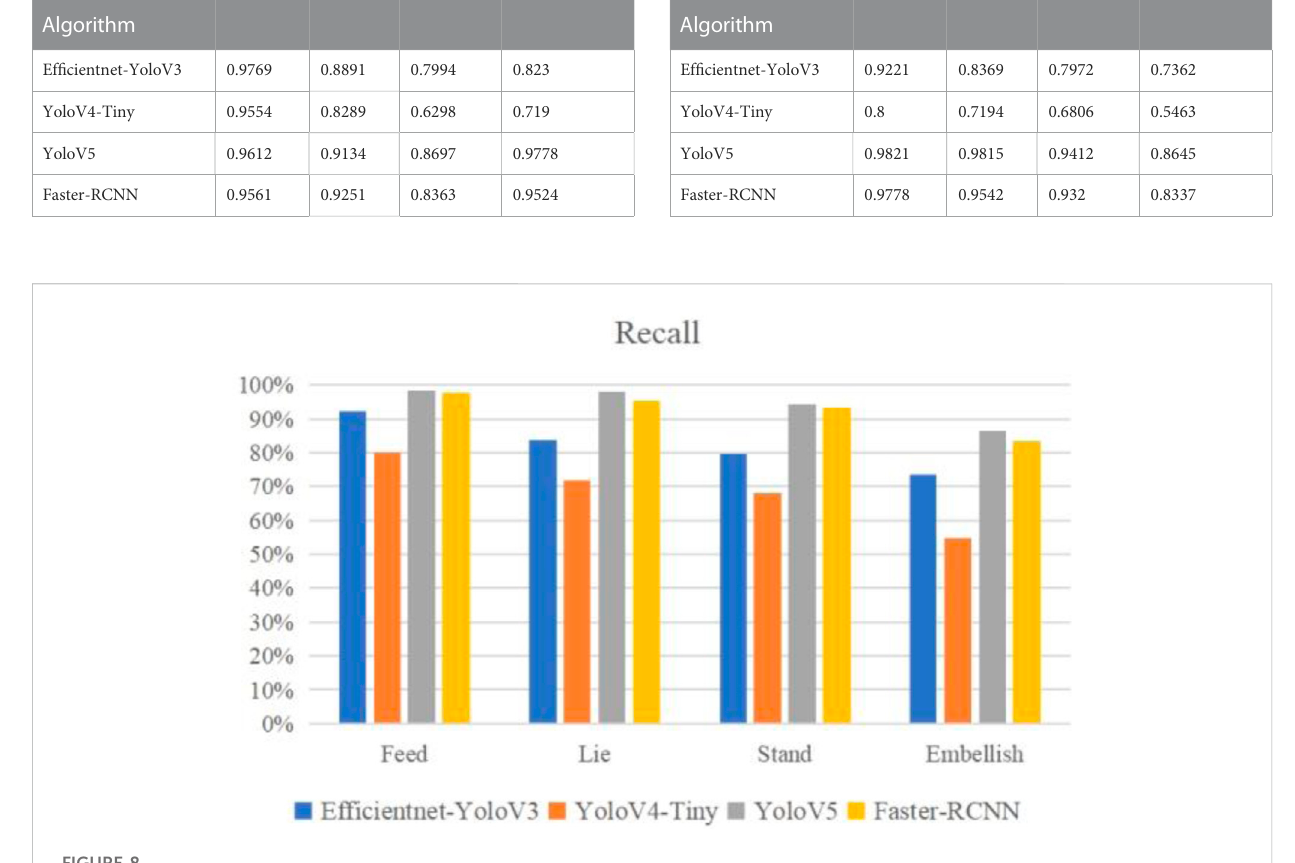
FIGURE 8 Comparison of the different algorithm Recall s for different behaviors.